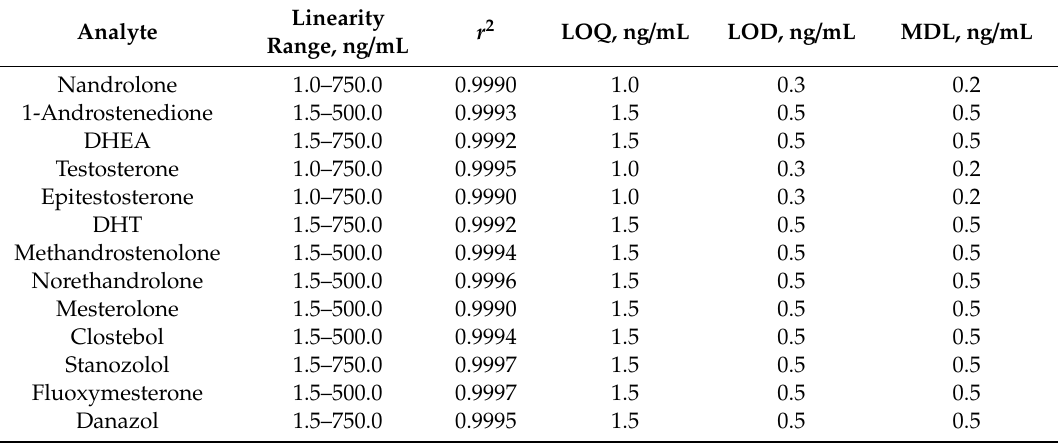
Table 4. Linearity, limit of quantification (LOQ), limit of detection (LOD), method detection limit